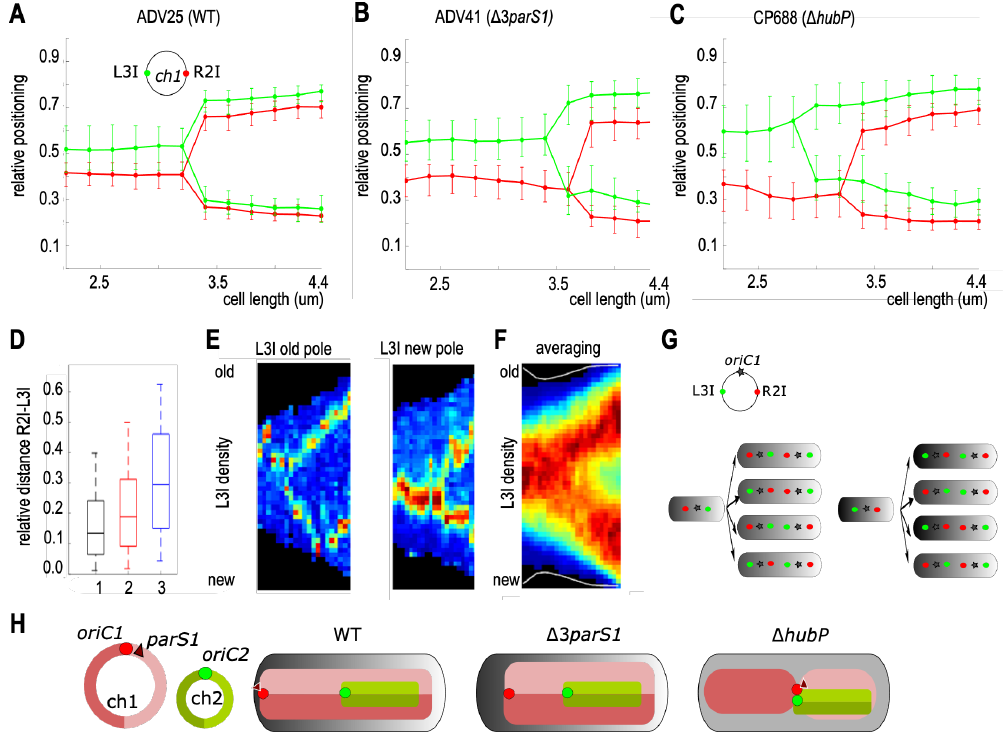
Figure 4. Global ch1 rearrangement in ∆ hubP cells. ( A – C ) Reconstituted choreographies of L3I and R2I foci in ADV25 (WT) ( A ), ADV41 ( ∆ parS1 ) ( B ) and CP688 ( ∆ hubP ) ( C ) from snapshots